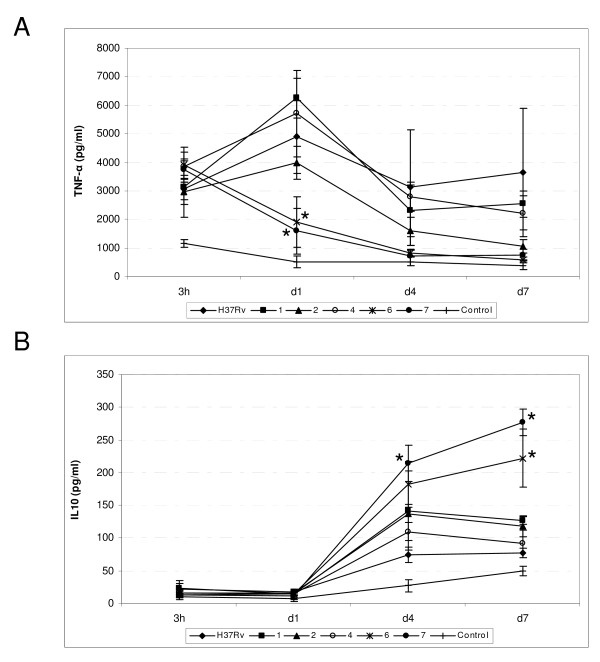
Cytokine production by differentiated THP-1 cells infected with strains representatives of different intracellular growth rates. Levels of TNF-α (panel A) and IL-10 (panel B) were determined in culture supernatants 3 hours after infection and at days 1, 4, and 7. Data are expressed as the mean ± standard error of three independent experiments per strain. Asterisks indicate significantly different (P < 0.05) cytokine production. Control: Non-infected control cells.